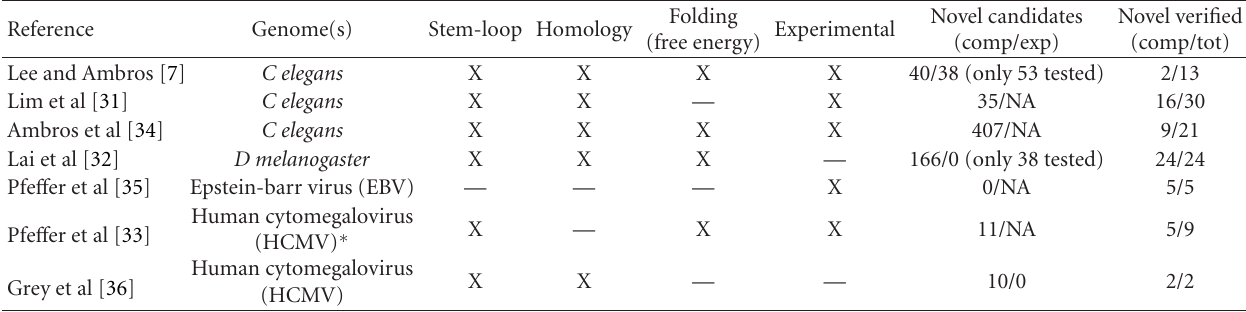
Table 1: Overview, in chronological order, of approaches and results of selected miRNA detection studies. Computational and experimental approaches used as well as the total number of predicted candidates and verified miRNAs are indicated for each study.